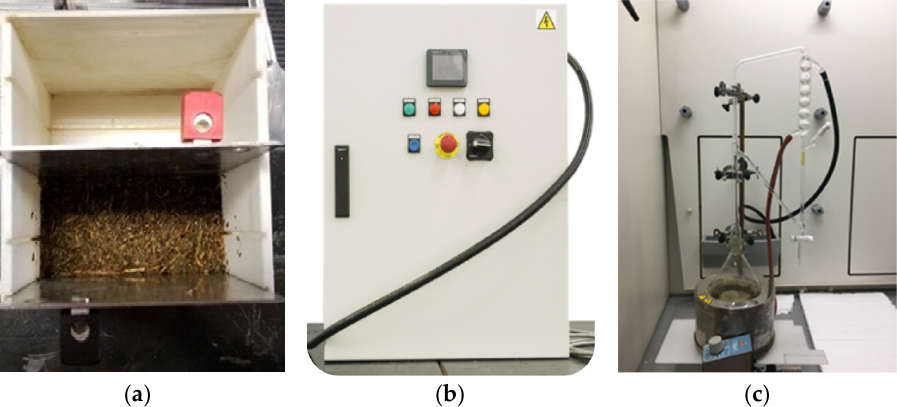
Figure 1. ( a ) Batch treatment chamber used for PEF application. ( b ) Pulsed generator used to apply HV pulses to the batch treatment chamber. ( c ) Clevenger apparatus used for the HD process for EO extraction from plants.